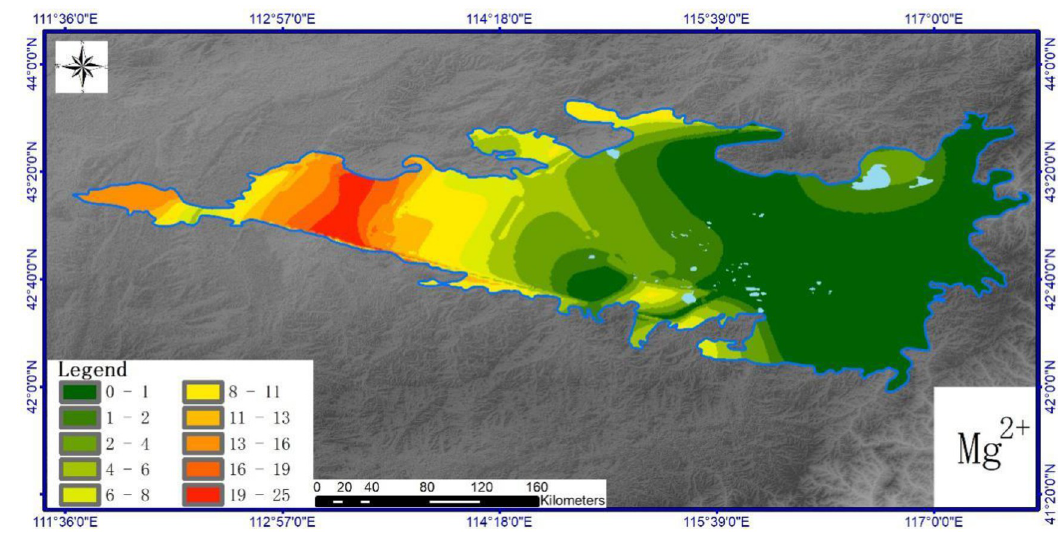
Fig 6. Spatial distribution of soil Mg 2+ in Hunshandake sandy land (Cartographic software:Arcgis10.5). https://doi.org/10.1371/journal.pone.0271562.g006 Average Na + and Ca 2+ values for 10–20 cm soil depth were 2.29 mg/kg and 0 mg/kg, respec- tively. This gives respective increases of 15.67% and -41.18% for Na+ and Ca 2 + relative to their 0–10 cm soil depth values. Na + content thus increased while Ca 2+ content decreased. Mean- while, no Mg 2+ was detected in 0–20 cm soil layers. Na + and Ca 2+ concentrations increased significantly at 20–30 cm depth (to 19.68 and 47.24 mg/kg, respectively). Mg 2+ increased to a value of 4.26 mg/kg in the 20–30 cm interval. K+ ions showed decreasing values with depth. Concentrations at 0–10 cm accounted for 41.37% of the total K+ ions in the profile range. This indicates significant surface accumulation of K+. The general trends described above relate to and accord with the character of the regional environment. Low silt and clay content in the